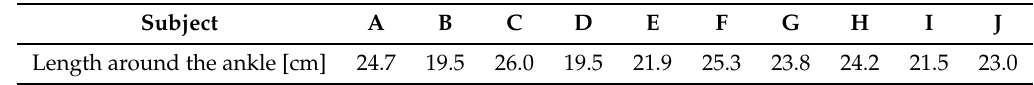
Table 8. Length around the ankle of each